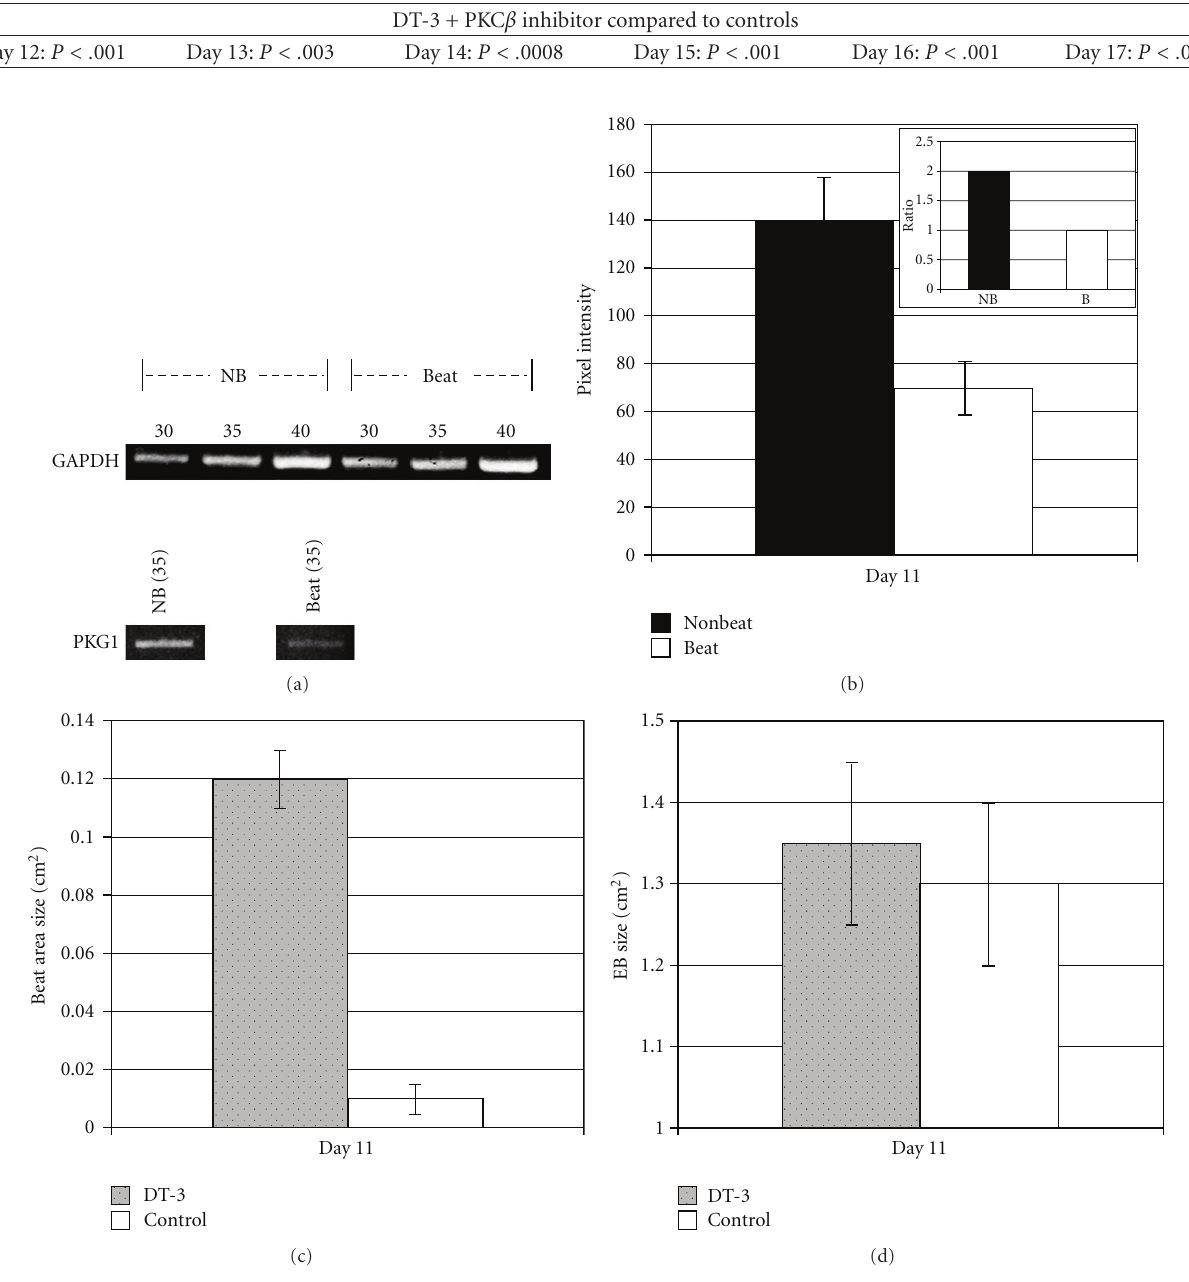
Figure 2: Gene expression was measured by semiquantitative RT-PCR using PKG1-specific primers. (a) Beating and nonbeating areas of similar sizes were dissected apart as described in [4, 10], followed by RNA isolation and quantification. Control GAPDH RT-PCR amplification revealed that 35 cycles were in the linear range and nucleotides in the PCR reaction were not exhausted. (b) After normalization to GAPDH levels, PKG1 mRNA levels were lower by approximately one-half in beating areas when compared to nonbeating areas (pixel intensity = 70 ± 11.0 to 139 ± 19.1, resp.). A representative ratio of PKG mRNA signal revealed 1.98X more in nonbeating areas when compared to beating areas (inset in (b)). (c) Inhibiting PKG1 resulted in dramatic and significant ( P < . 005) increase in the size of beating areas within EBs; however, the total size of EBs was not changed by PKG inhibition